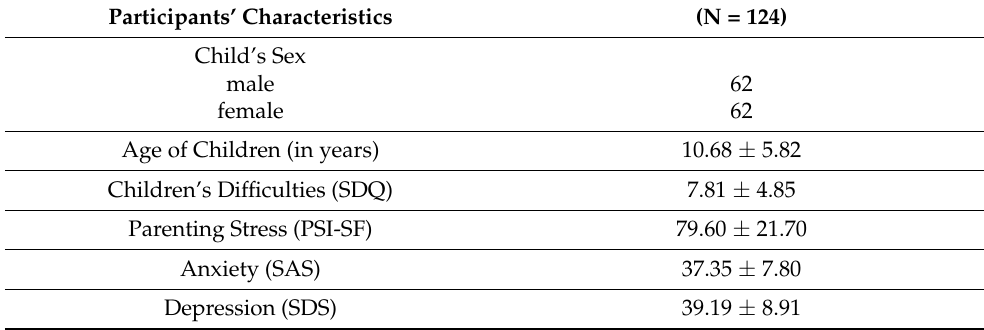
Table 1. Cont. Participants’ Characteristics